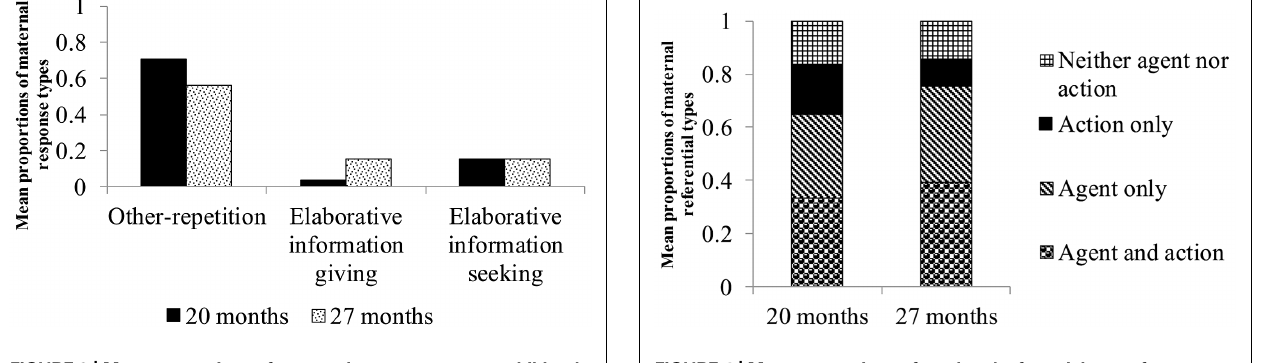
FIGURE 4 | Mean proportions of mothers’ referential types for information-giving utterances about a